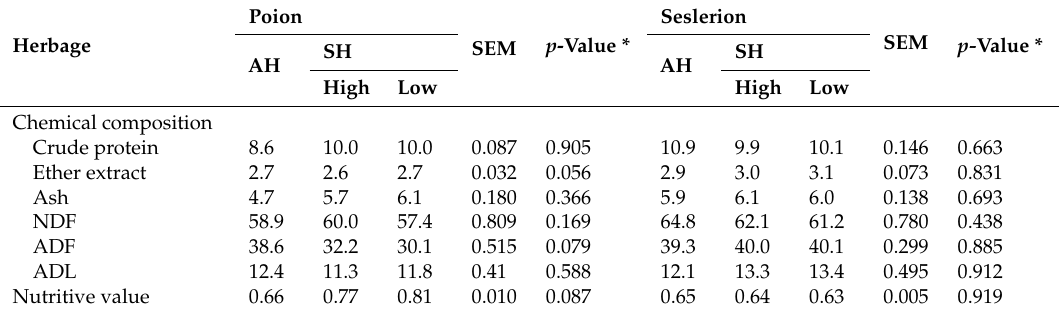
Table 2. Chemical composition (% DM) and nutritive value (FUM/kg DM) of herbage consumed by cows in two pastures (Poion and Seslerion), as affected by different concentrate levels (High and Low). Poion Seslerion SEM p- Value * Herbage SEM p -Value * SH SH AH AH High Low High Low Chemical composition Crude protein 8.6 10.0 10.0 0.087 0.905